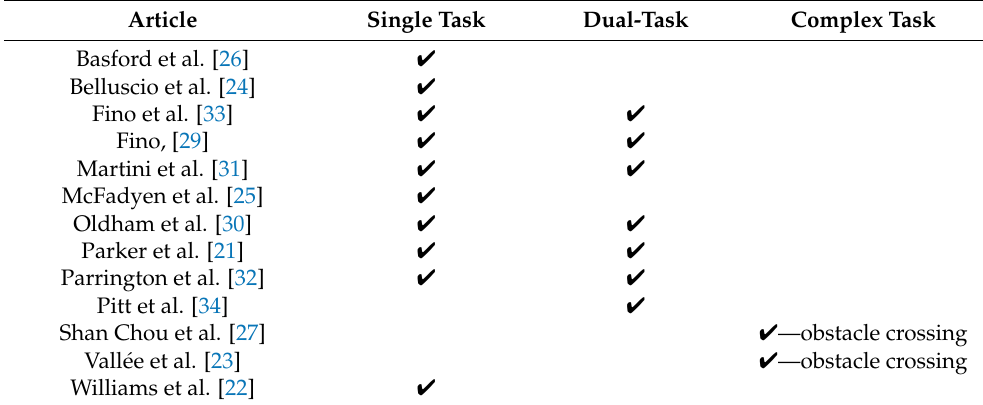
Table 3. Objective gait task